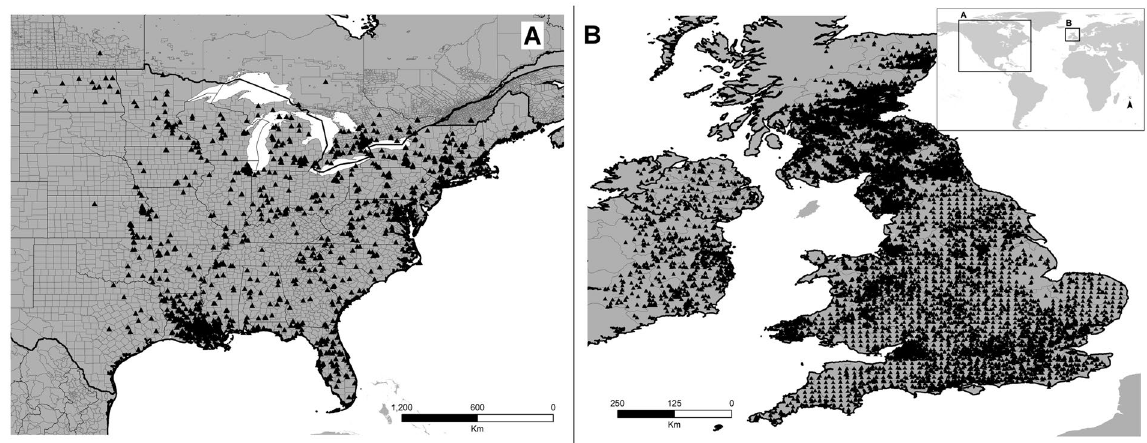
Figure 4. Study area and Gray Squirrel occurrences (black triangles) used to compare the native ( A ) North America) and invaded ( B ) United Kingdom & Ireland) ranges. Insert shows the geographic location of the study areas. Figure done using ArcGIS 10.2 (ESRI, Redlands, CA,